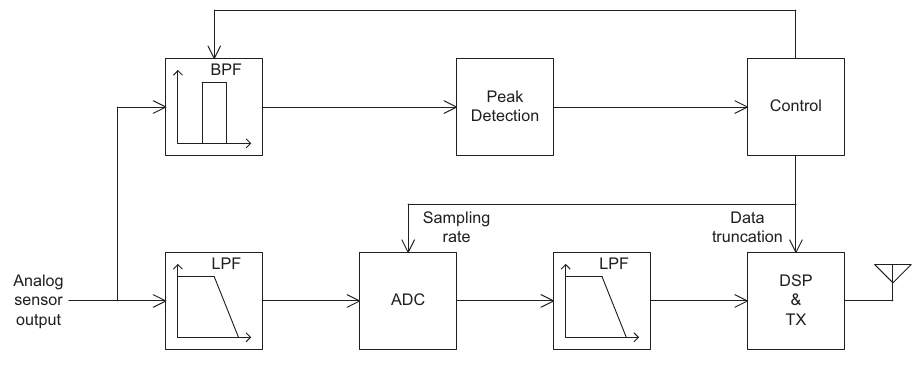
Figure 4. Sensor node circuit used in the proposed quality enhancement framework.